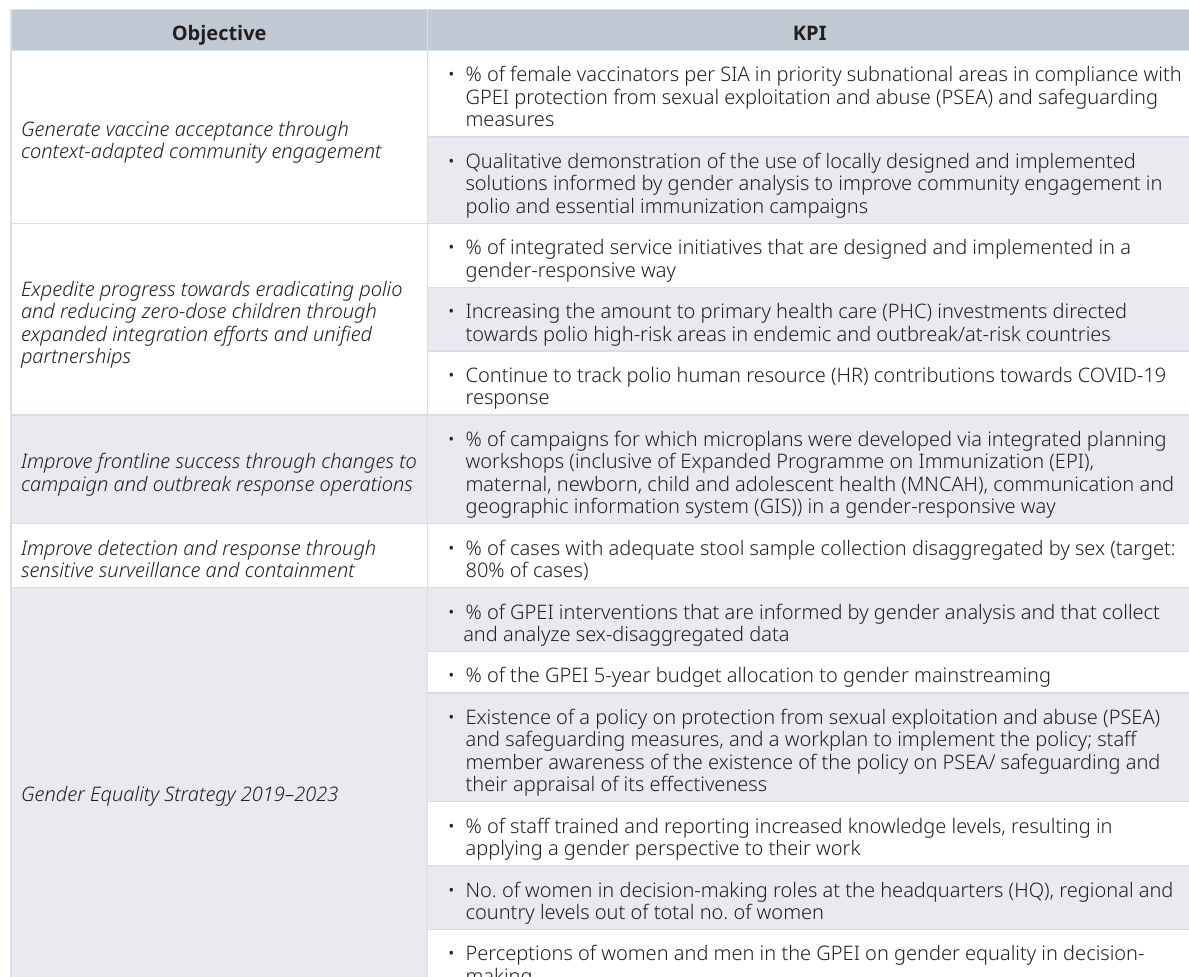
Table 2. Non-polio-specific objectives and key performance indicators (KPIs) from the GPEI Polio Eradication Strategy 2022–2026 10